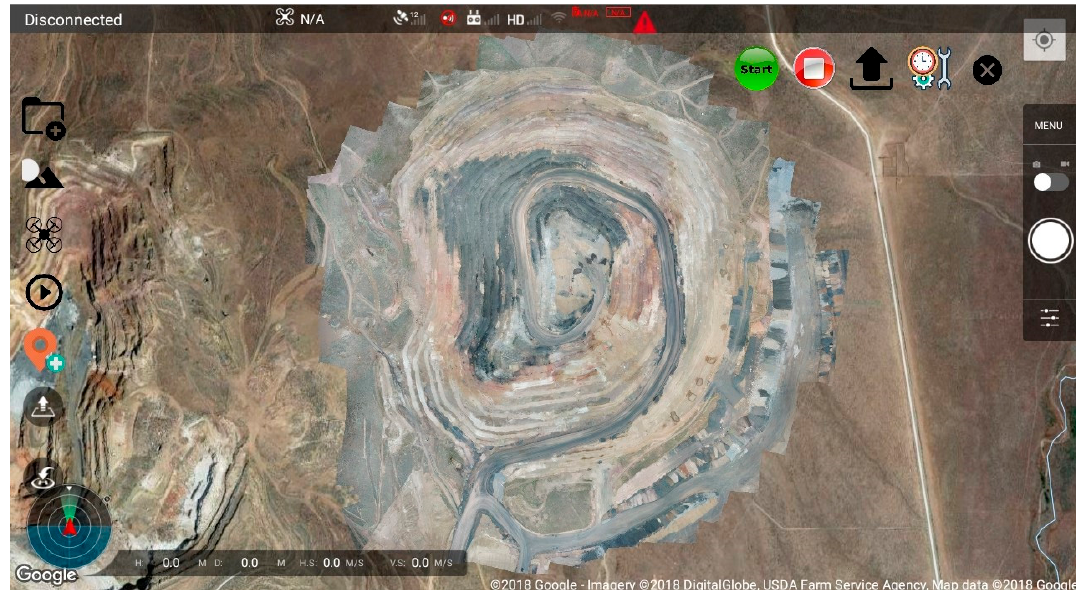
Figure 4. Graphical User Interface of the designed application with updated mine terrain.